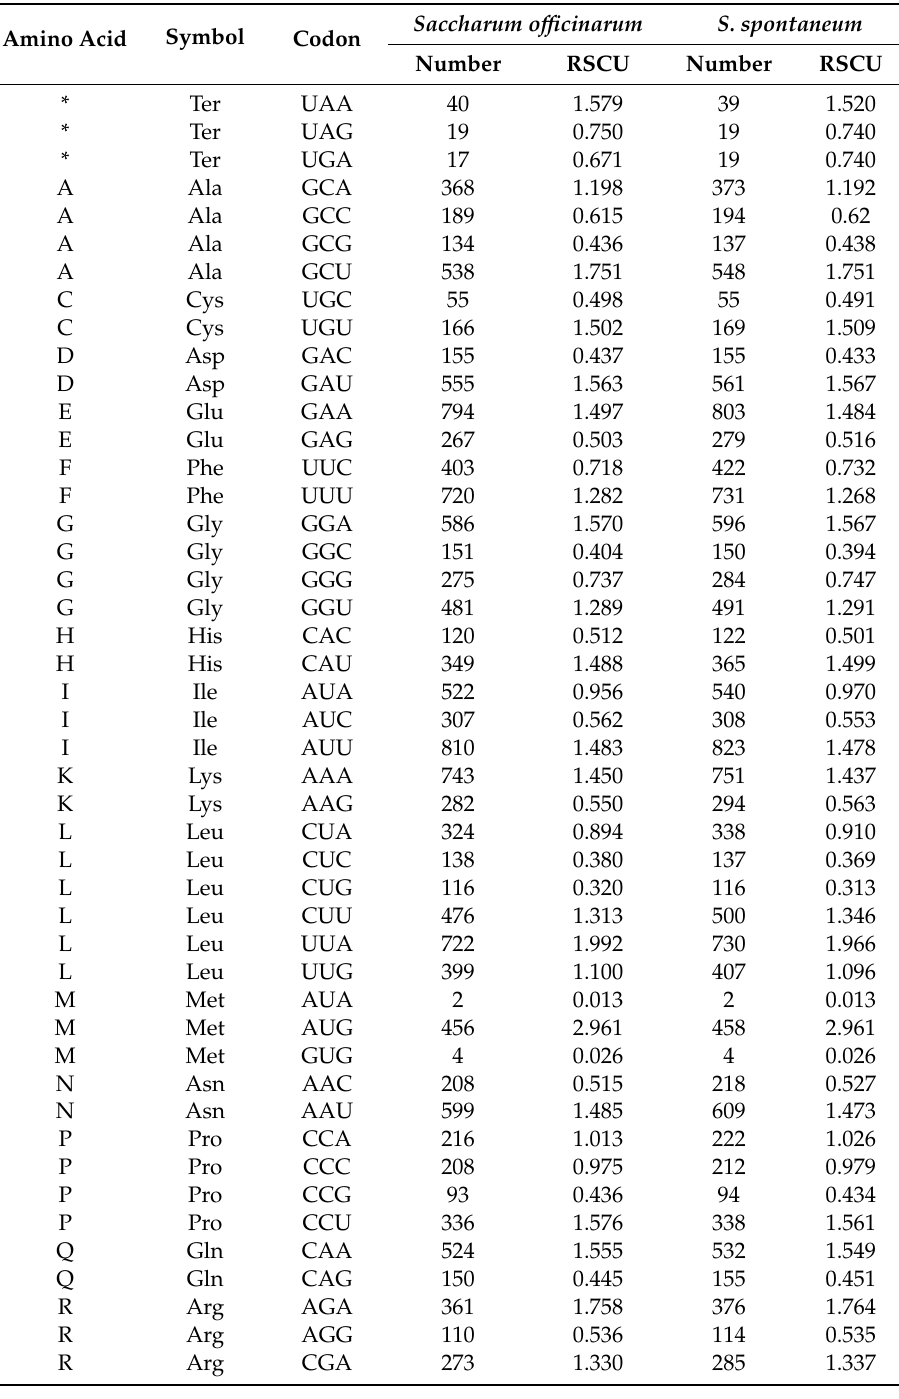
Table 3. Coding capacity of protein coding genes (PCGs) and relative synonymous codon usage